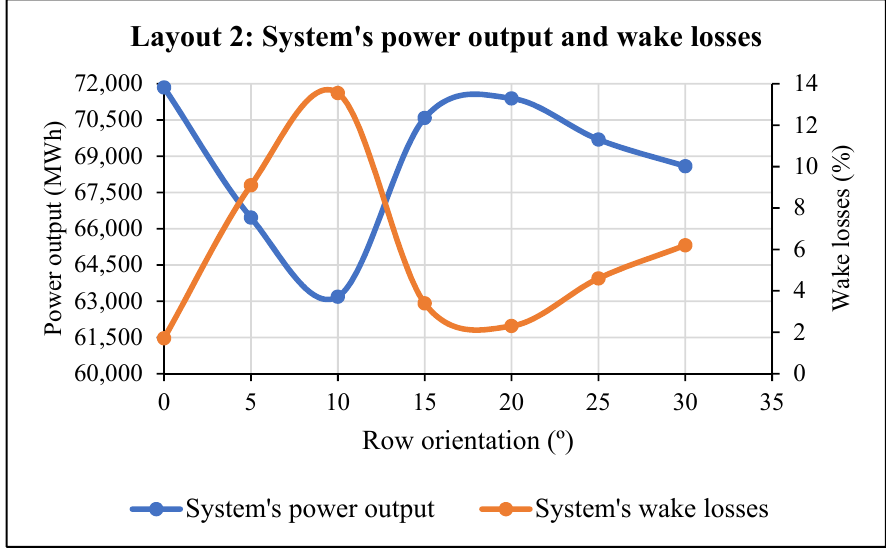
Figure 16. System’s power output for different rows orientation angles.